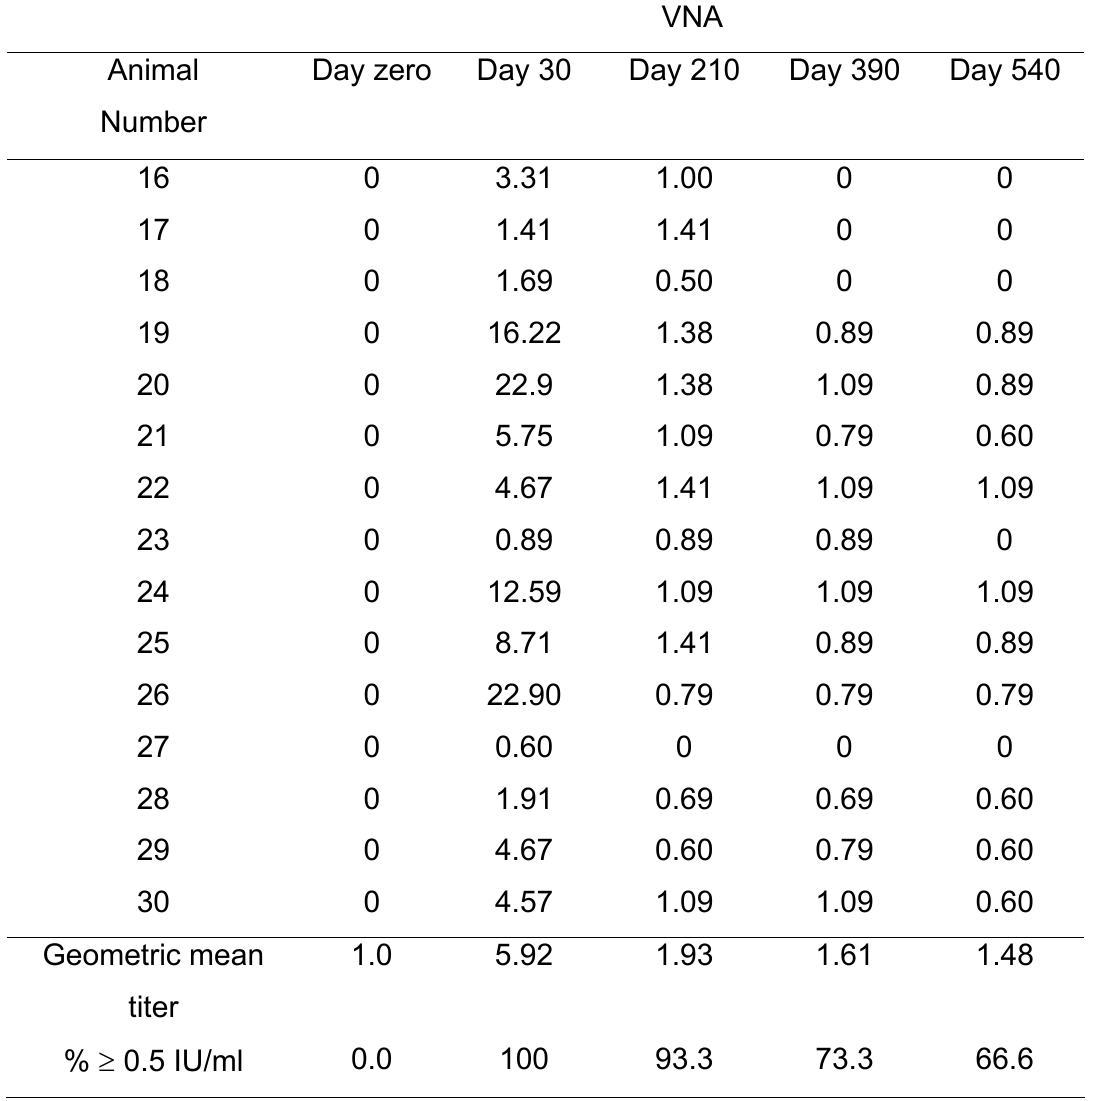
Table 2: Virus neutralizing antibody (VNA) titers in cattle that received a booster 30 days after the primary immunization (Group